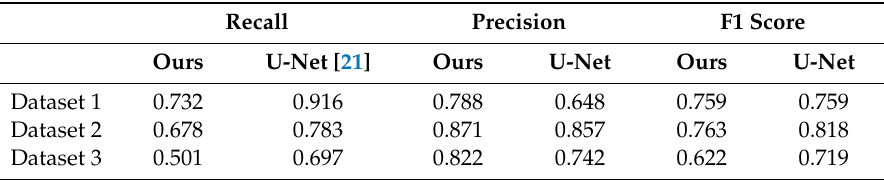
Table 1. Performance comparison of the two methods.